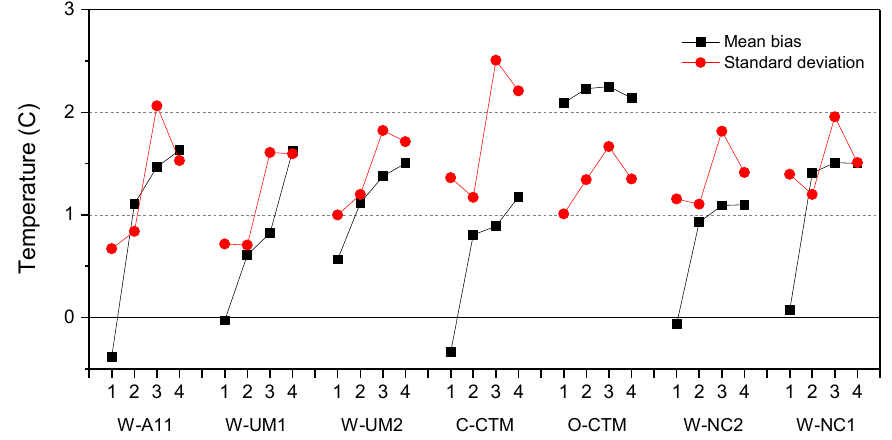
Figure 5. µ MB and σ MB of 2 m temperature at Westmead for each model. Numbers on the abscissa for each model represent the radon-based mixing states (categories #1 to #4) in Table 1.